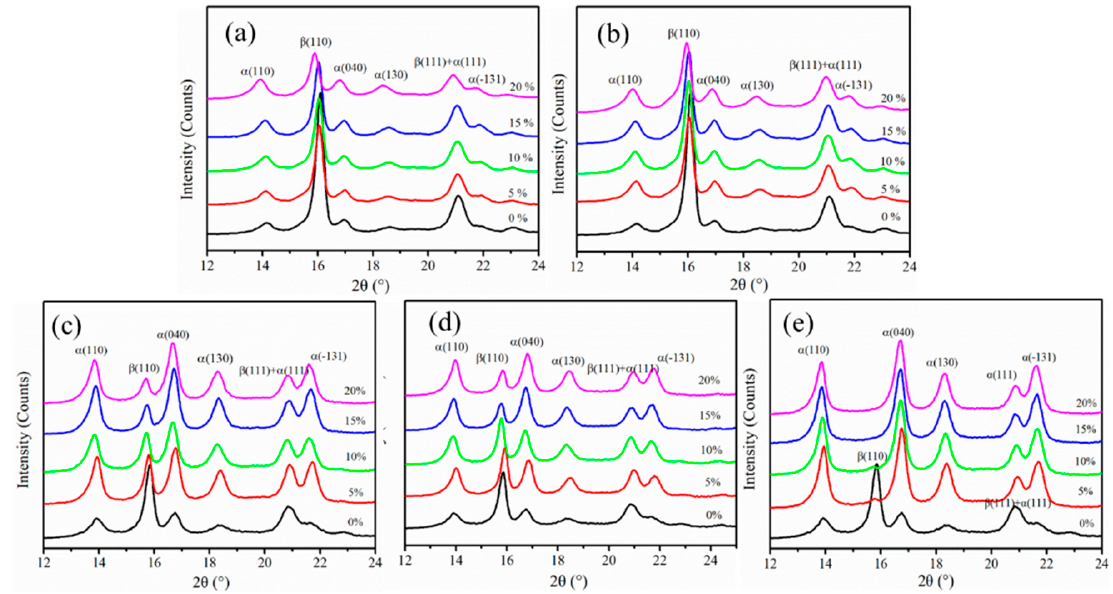
Figure 1. X-ray diffraction (XRD) curves of the isotactic polypropylene (iPP) sheet after stretching at different temperatures: ( a ) 110 °C, ( b ) 120 °C, ( c ) 130 °C, ( d ) 140 °C, and ( e ) 150 °C.